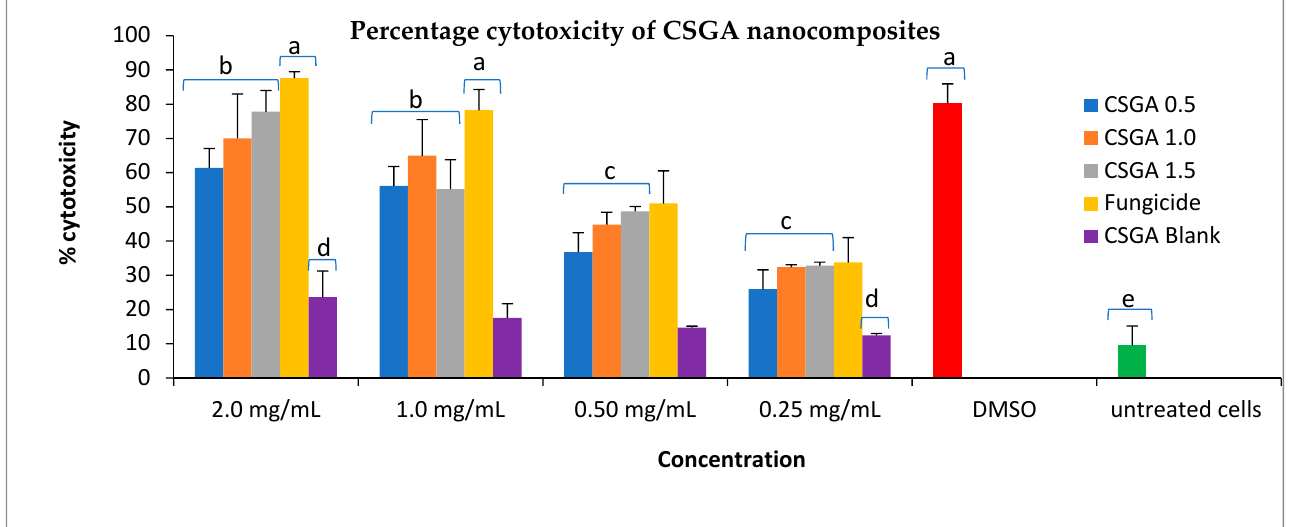
Figure 9. Percentage cytotoxicity of CSGA nanocomposites against the Vero cell line. Caps on bars represent SD. Same letters in graph column of each treatment are not significantly different at p ≤ 0.05, according to the t -test.